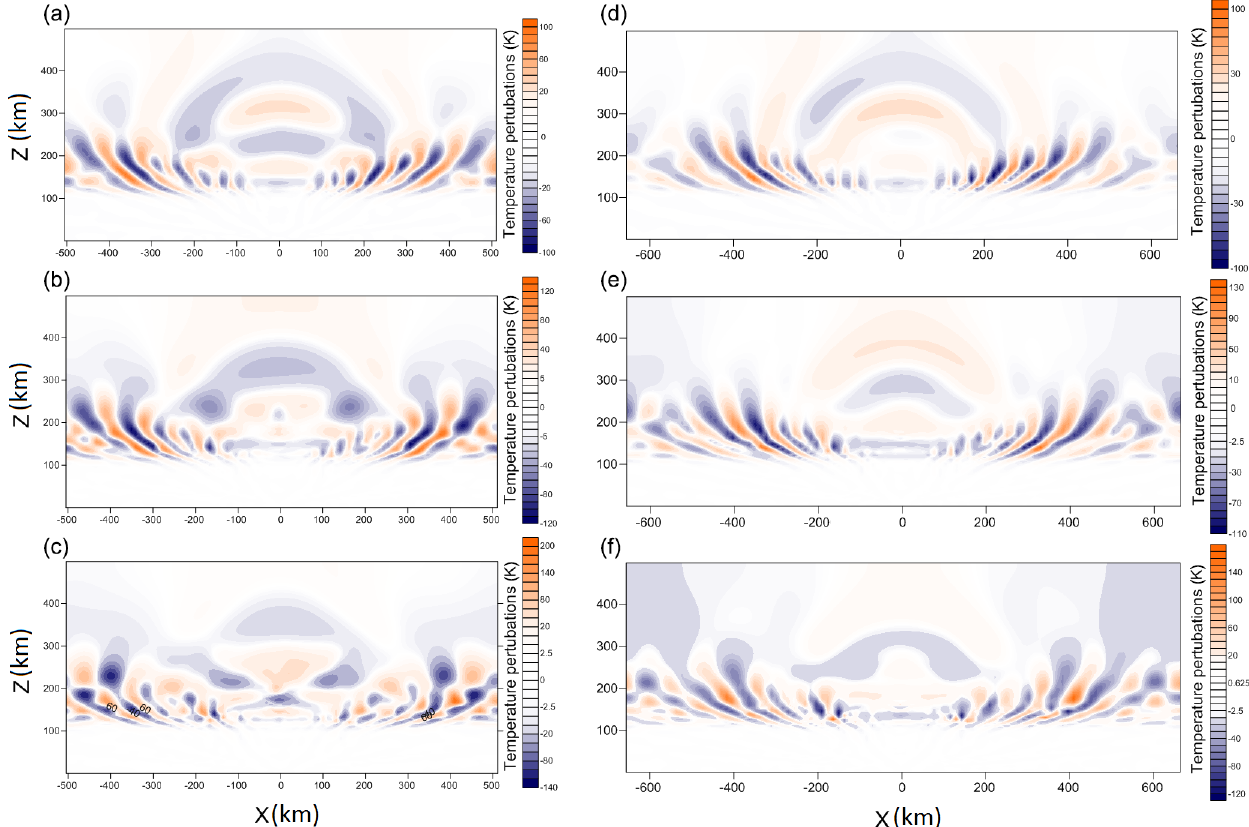
Figure 5. The plane y = 0 of the cross section of the temperature field at (a) t = 1h 30min, (b) t = 2h, and (c) t = 2h 30min for the area of 1020km × 1020km, and the plane y = 0 cross section of the temperature field at (d) t = 1h 30min, (e) t = 2h, and (f) t = 2h 30min for the area of 1320km ×